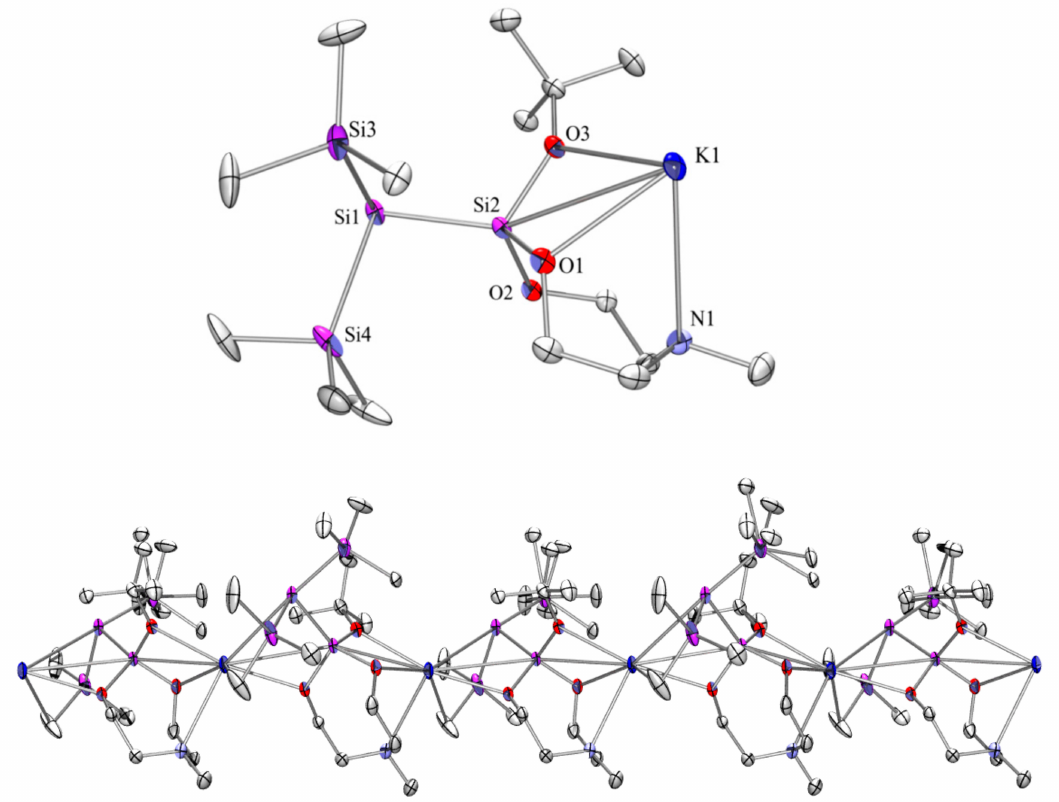
Figure 6. Molecular structure of 12 (thermal ellipsoid plot drawn at the 30% probability level) above and packing plot below. All hydrogen atoms are omitted for clarity (bond lengths in Å, angles in deg.). K(1)-O(1) 2.692(2), K(1)-O(3) 2.699(2), K(1)-O(2)#1 2.727(2), K(1)-N(1) 2.990(3), K(1)-Si(1)#1 3.4702(11), K(1)-Si(2) 3.4942(11), 1.437(4), O(2)-Si(2) 1.683(2), O(3)-Si(2) 1.664(2), Si(1)-Si(2) 2.3052(12), Si(1)-Si(4) 2.3437(13), Si(1)-Si(3) 2.3544(12), Si(2)-Si(1)-Si(4) 102.27(5), Si(2)-Si(1)-Si(3) 99.17(4), Si(4)-Si(1)-Si(3) 100.73(5), O(3)-Si(2)-O(1) 95.56(10), O(3)-Si(2)-O(2) 106.19(10), O(1)-Si(2)-O(2) 104.11(11).